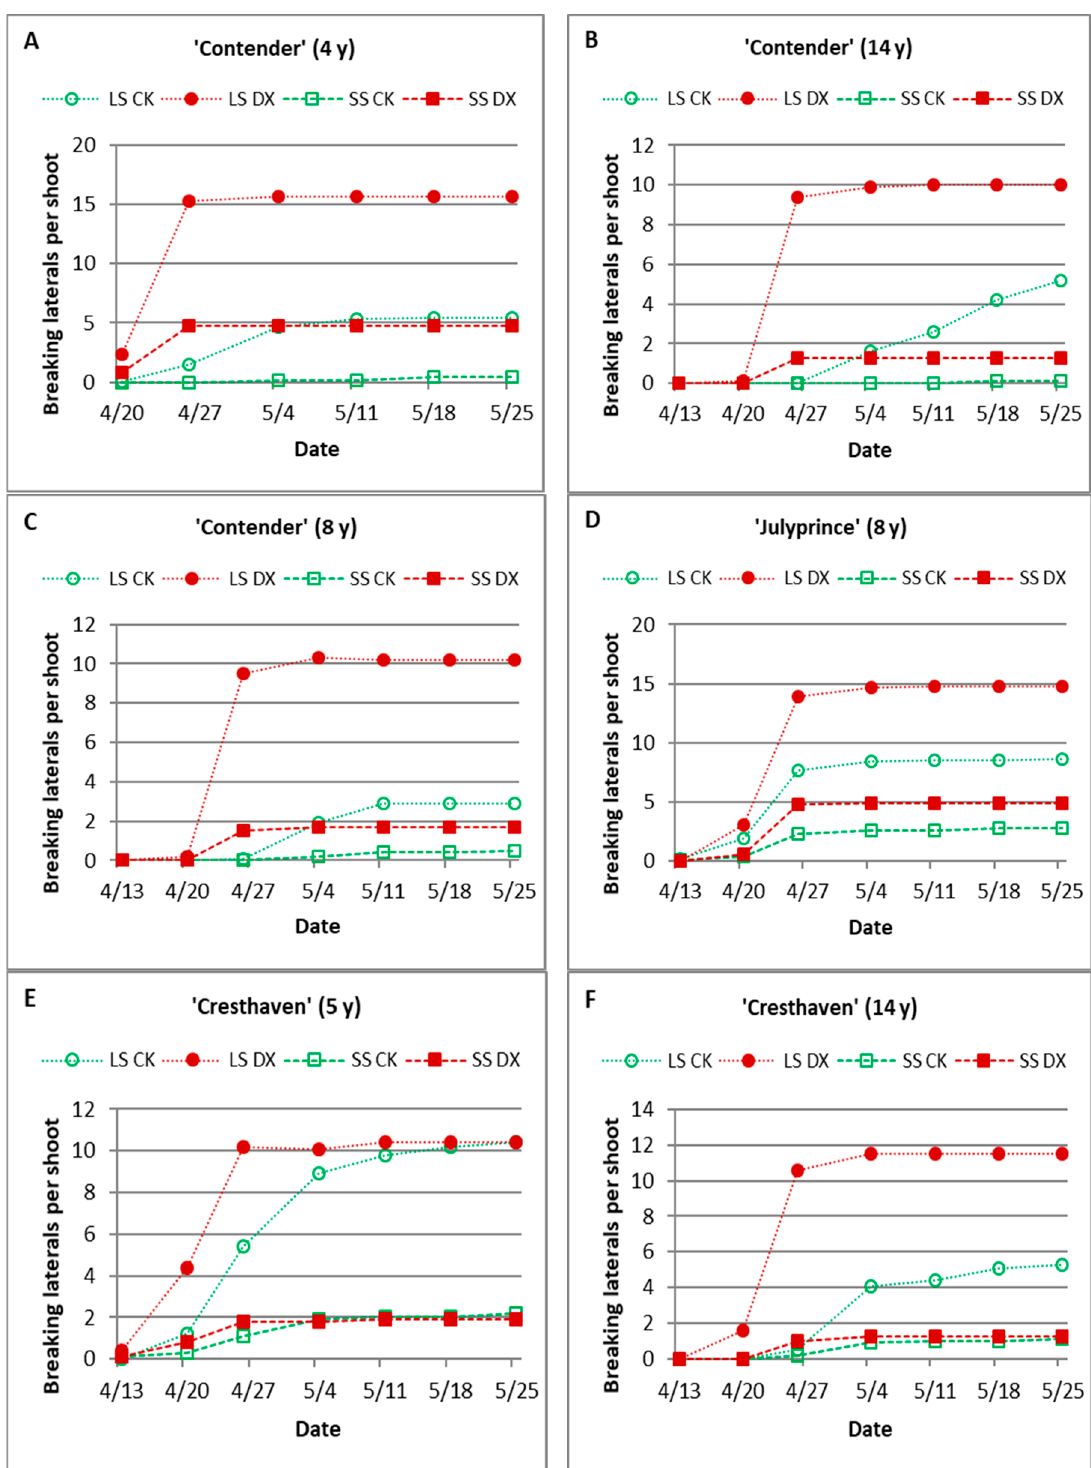
Figure 2. Averages of cumulative breaking laterals per shoot in ‘Contender’ (4 year old, 1050 chill hours) ( A ), ‘Contender’ (14 y) ( B ), ‘Contender’ (8 y) ( C ), ‘Julyprince’ (8 y, 850) ( D ), ‘Cresthaven’ (5 y, 950) ( E ), and ‘Cresthaven’ (14 y) ( F ) on the seven sampling days. Almost no breaking lateral buds or opened flowers were observed on Apr 13, 2017 (4/13 on the x axis) when Dormex was sprayed. LS—long shoot; SS—short shoot; CK—unsprayed control; DX—Dormex sprayed. The count of newly breaking but dying lateral buds increased in the sprayed long and short shoots, compared to their unsprayed controls (Figure 1B). For example, on 5/25 the average count of breaking but dying lateral buds in sprayed long and short shoots was 0.17 and 0.10, whereas those in